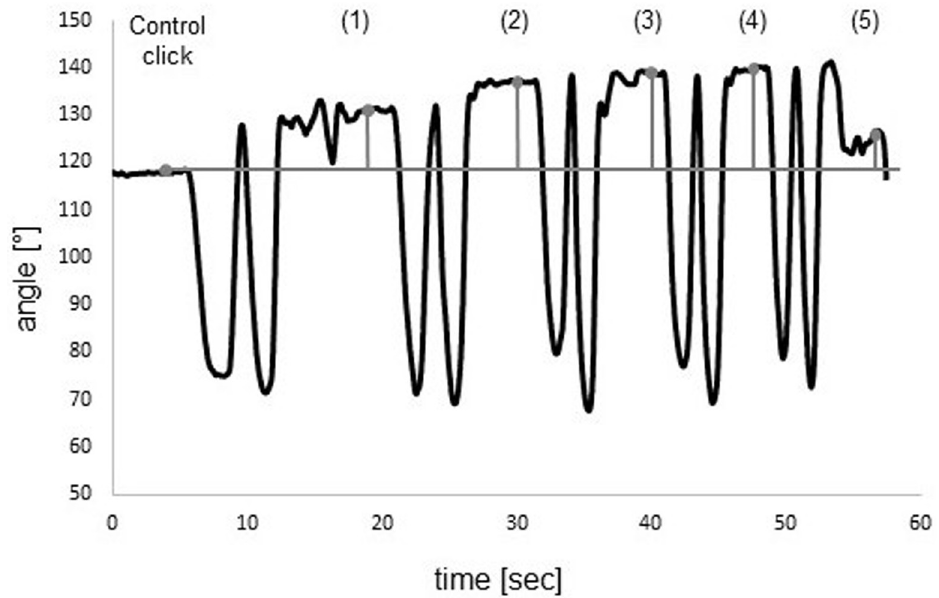
Fig 5. Large deviation in neutral head repositioning. Black line : Row angle between head and chair markers during measurement. Gray line : Control click and five consecutive clicks to confirm position. Deviation from black line to grey line represents the deviation of the row between-marker angle to the control angle. Mean deviation (absolute error): 8.1˚.